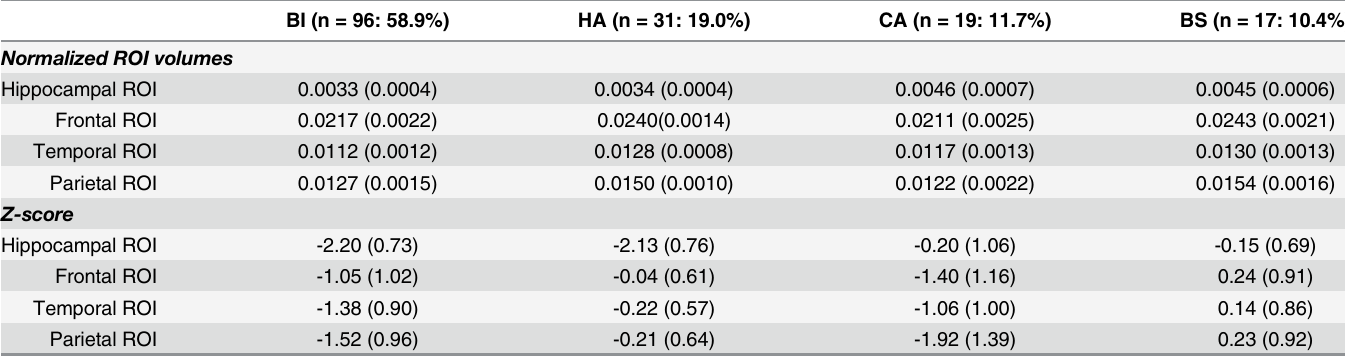
Table 2. Mean normalized ROI volumes and Z-scores of AD